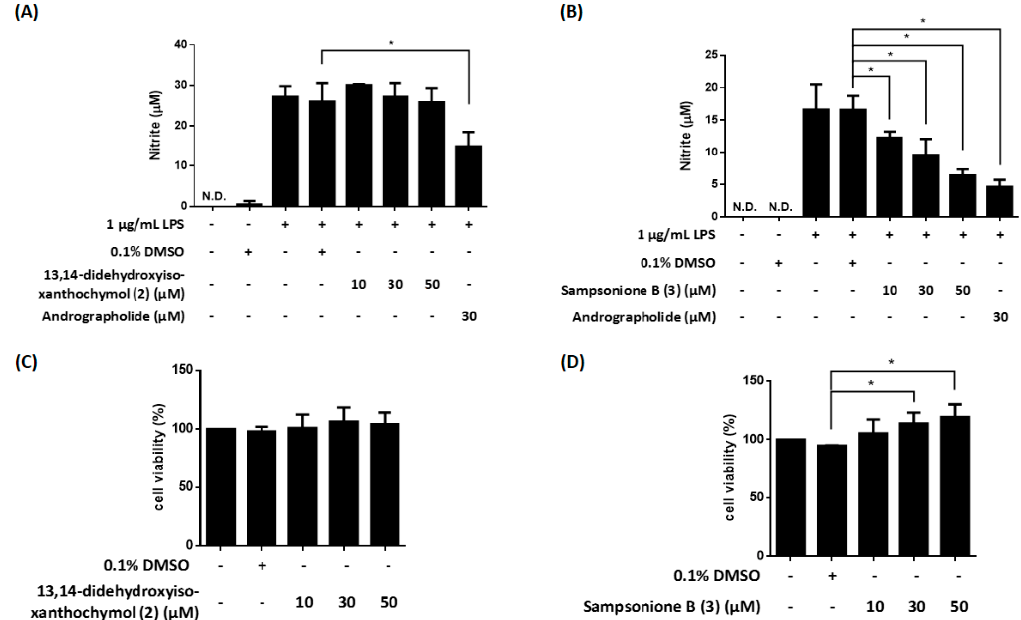
Figure 9. The effects of compounds 2 and 3 on nitric oxide (NO) production in LPS-induced RAW 264.7 macrophages. The effects of 13,14-didehydroxyisoxanthochymol ( 2 ) ( A ) and sampsonione B ( 3 ) ( B ) in LPS-treated RAW 264.7 macrophages were detected by Griess reagent. Andrographolide is the positive control. The cell viability of RAW 264.7 cells incubated with 13,14-didehydroxy- isoxanthochymol ( 2 ) ( C ) or sampsonione B ( 3 ) ( D ) for 24 h was measured using MTT assay. * indicates significant difference vs. LPS-treated vehicle control ( p < 0.05).